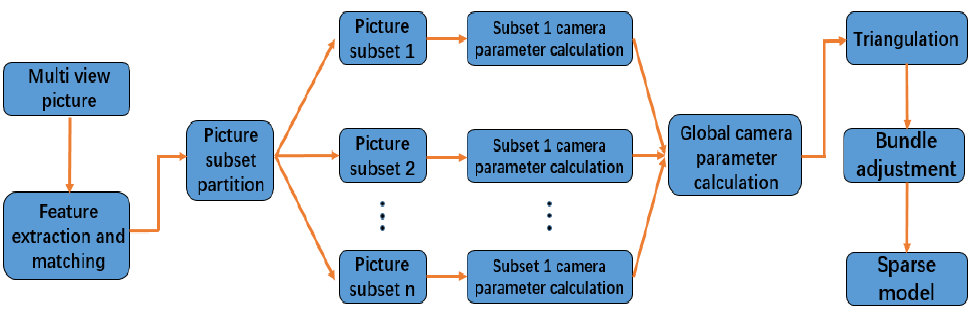
Figure 3. The flow chart of the hybrid SFM algorithm.